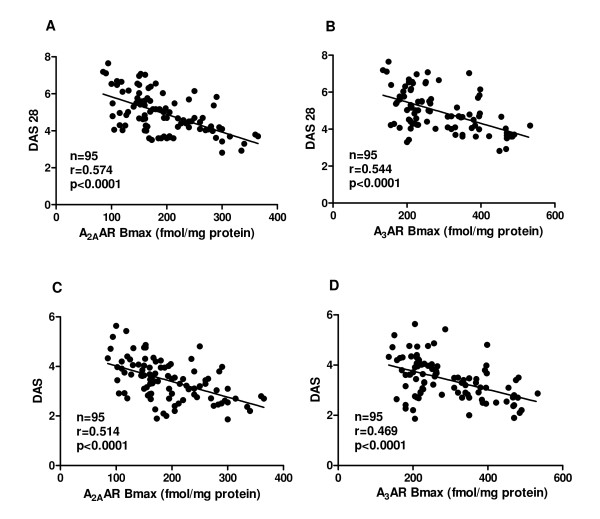
Correlation between DAS28 or DAS and A2A or A3AR density. Linear regression analysis between DAS28 or DAS and the receptor density expressed as Bmax (fmol/mg protein) of A2A (A, C) and A3ARs (B, D) in lymphocytes from 32 ERA and 63 RA patients considered as a whole.